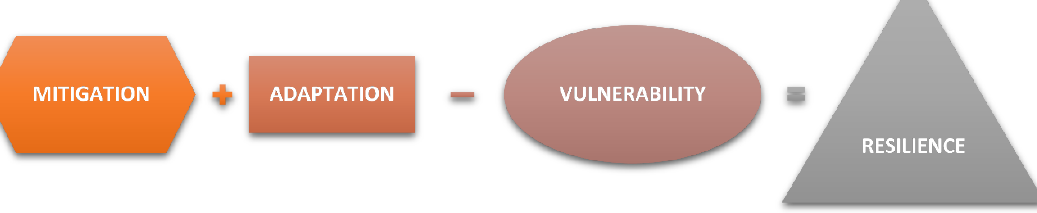
Figure 5. The influential factors of precinct resilience.